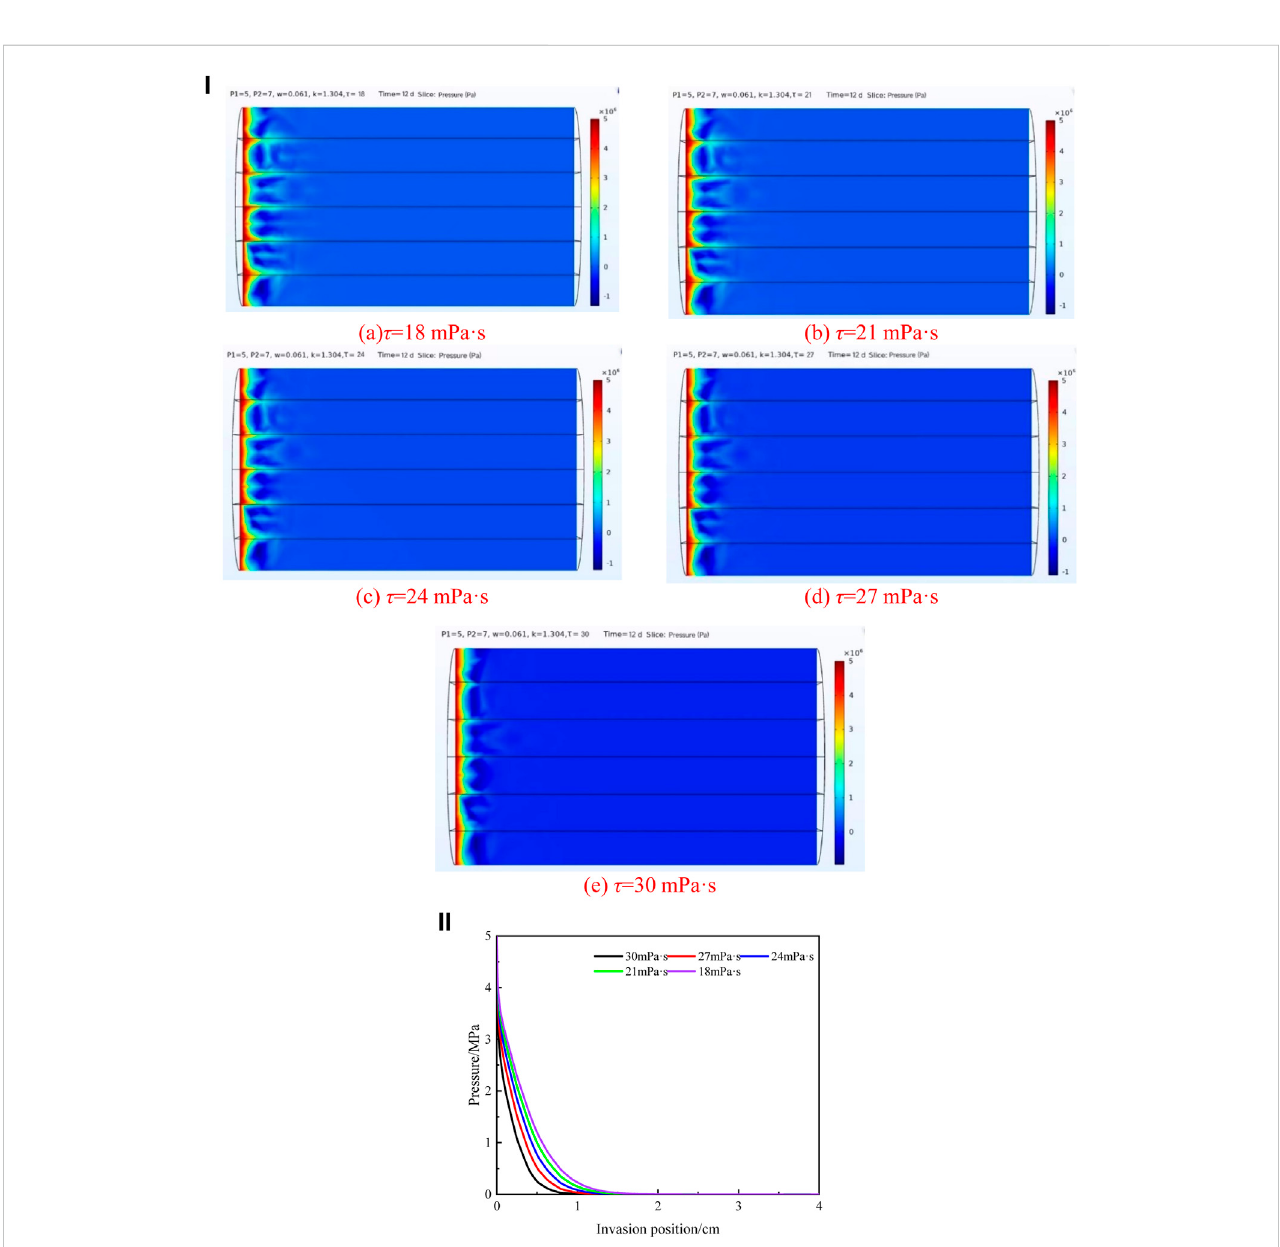
FIGURE 13 (i) : Clouddiagramoftheinvasioneffectunderdifferentviscositiesofthedrilling fl uid. (A) τ =18 mPa · s, (B) τ =21 mPa · s, (C) τ =24 mPa · s, (D) τ =27 mPa · s, and (E) τ = 30 mPa · s. (ii) : Changes of fl uid pressure between bedding fractures with the invasion position under different viscosities of the drilling fl